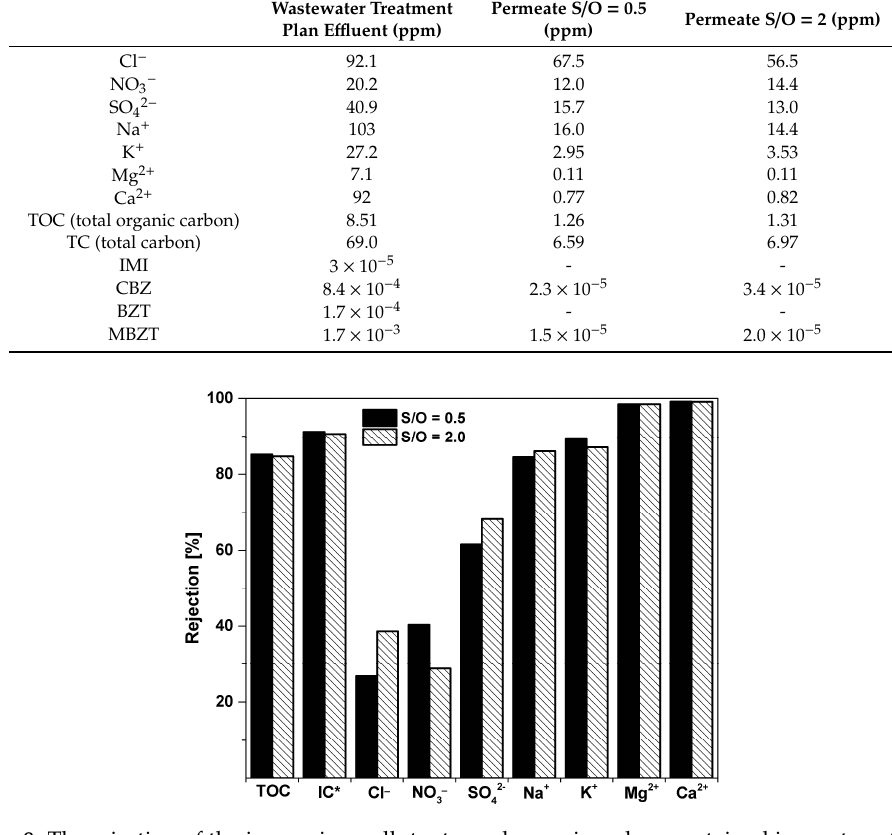
Figure 8. The rejection of the ions, micropollutants, and organic carbon contained in wastewater for the optimized membranes. IC* (inorganic carbon) = TC − TOC.